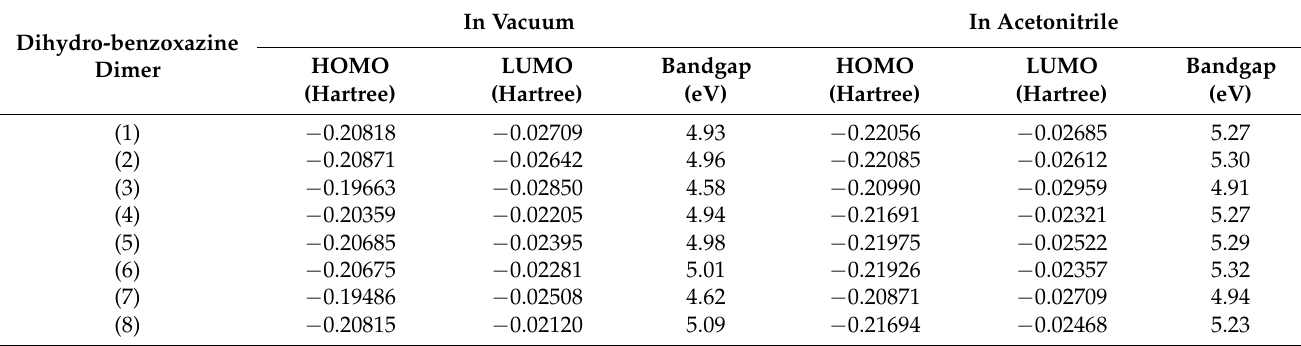
Table 7. Calculated HOMOs, LUMOs, and bandgap energies of the dihydro-benzoxazine dimers in vacuum and acetonitrile. Dihydro-benzoxazine